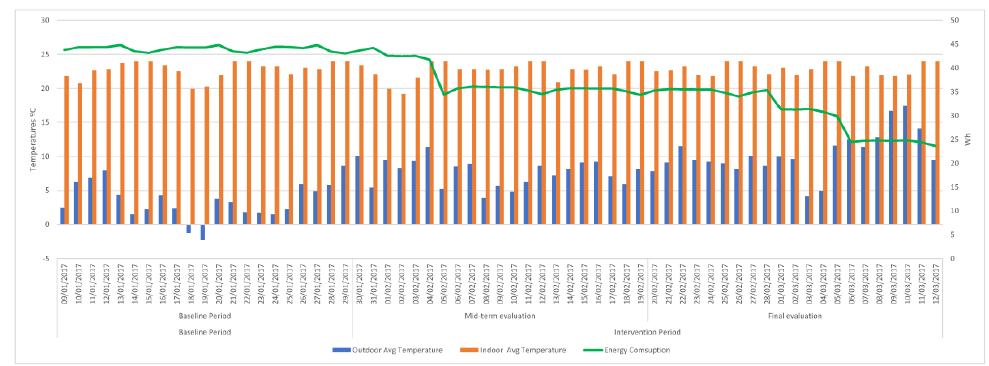
Figure 13. Energy consumption during the different periods of the experiments in office 4.